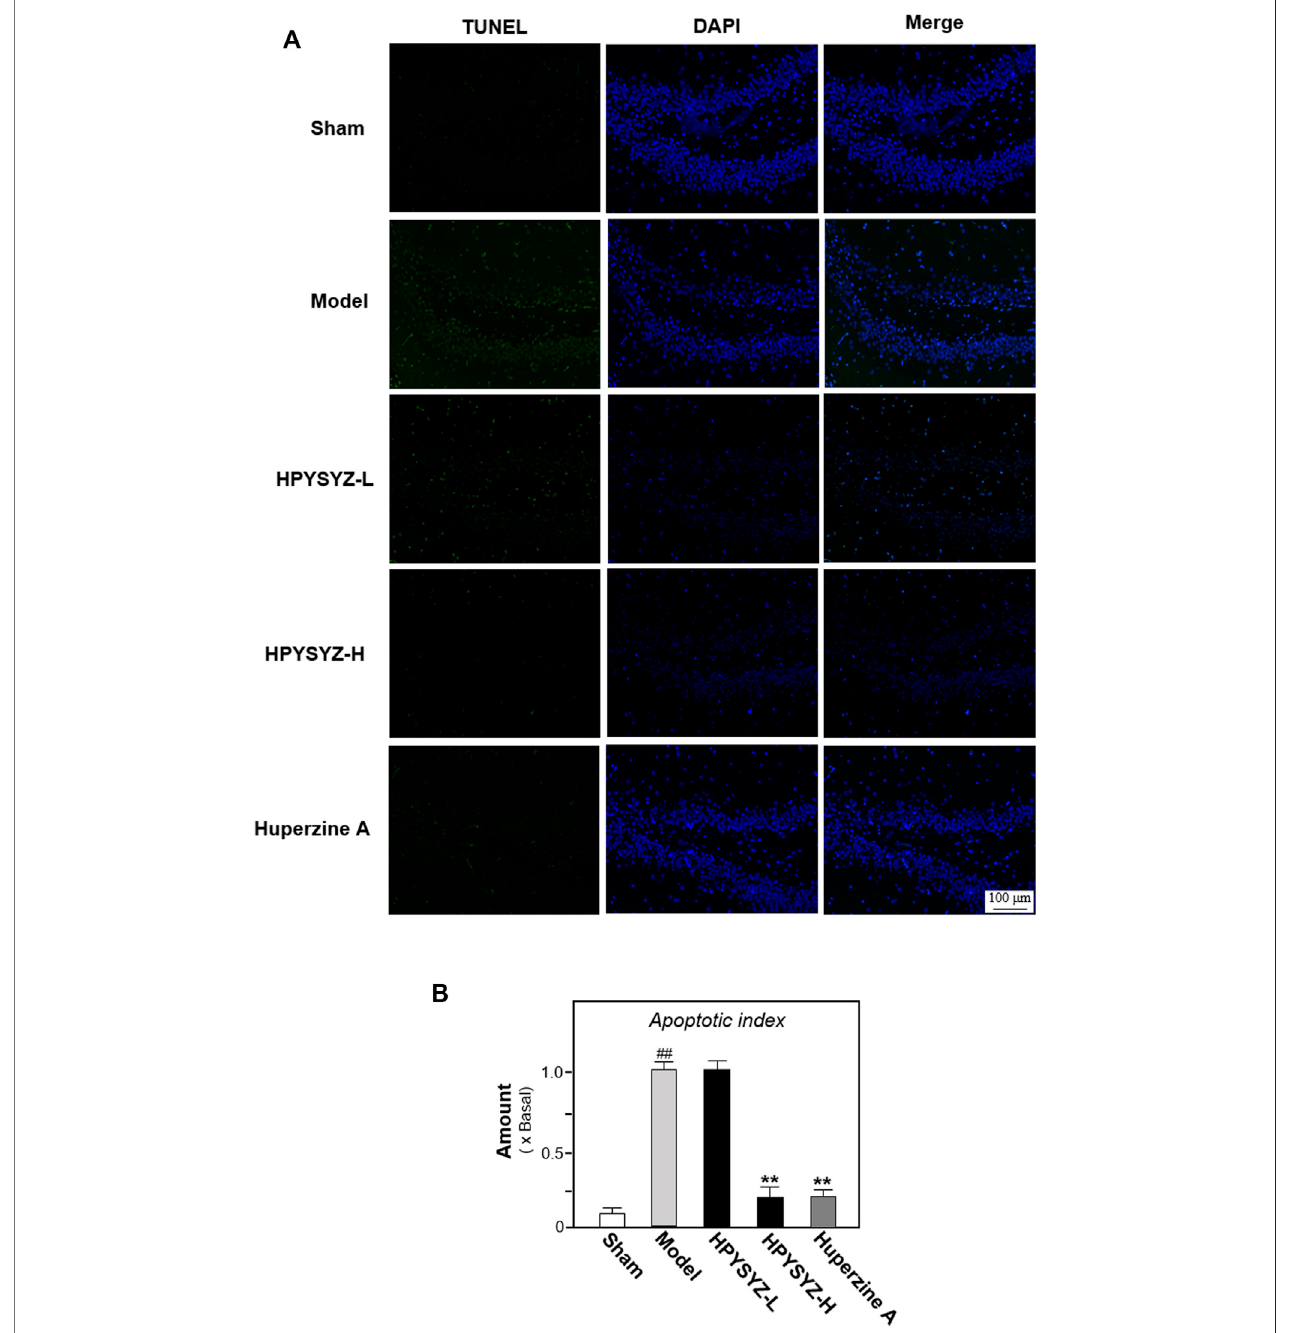
FIGURE2 | Ethyl acetate extracts ofsuccinum reduced theapoptosis inthe hippocampus ofcarotid artery ligationrats. (A) Apoptosis ofthehippocampal dentate gyrus of rats in the sham control group, model group, low dose and high dose treatment of ethyl acetate extracts of succinum groups, and positive control huperzine A group were determined by TUNEL assays. (B) Percentage of TUNEL staining positive cells to DAPI-staining positive cells was calculated for apoptosis evaluation. The low dose treatment of ethyl acetate extracts of succinum (HPYSYZ-L) was set as 0.21 g/kg/d, and the high dose treatment (HPYSYZ-H) was set as 0.42 g/kg/d ( n = 3). The analysis was performed from two brain sections of one rat and three rats from one group (mean ± SD, * p < 0.05, and ** p <